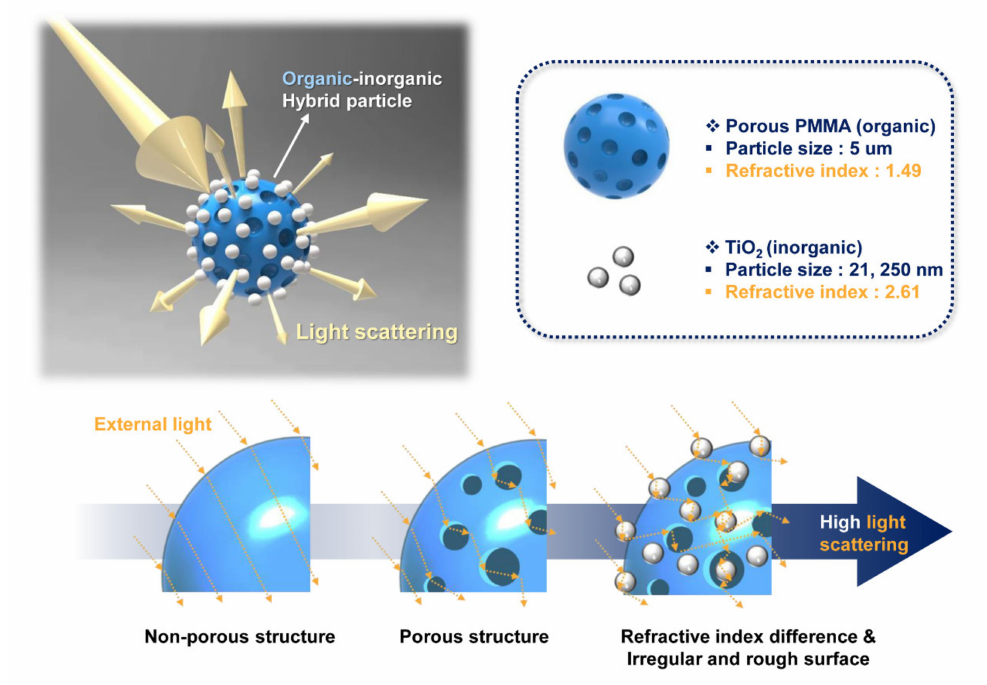
Figure 1. Schematic of a hierarchical organic-inorganic hybrid polymer microsphere with an excellent light scattering